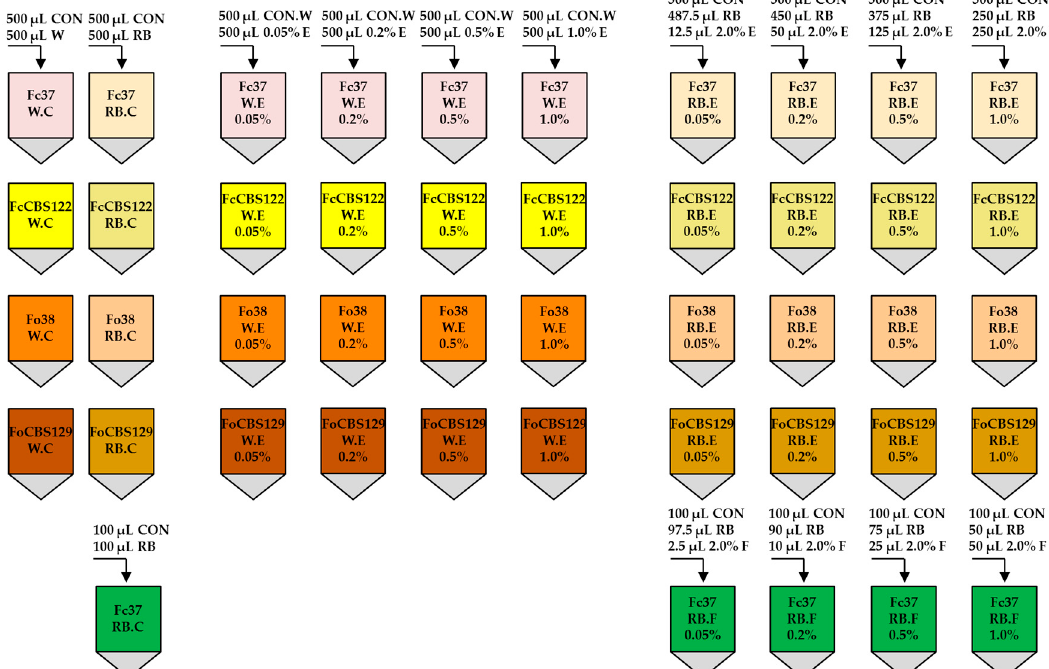
Figure 1. The diagram of studied samples (W—water; RB—medium; W.C—water control; RB.C—RB control; E—extract; F—fucosterol; CON—conidia; CON.W—conidia suspended in water).